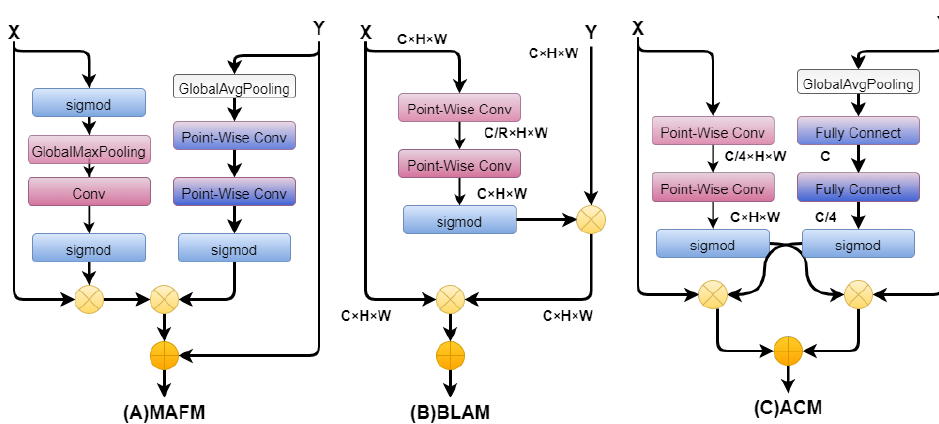
Figure 2. Illustration of different fusion methods. Although the three fusion structures look very similar, they are fundamentally different in terms of design